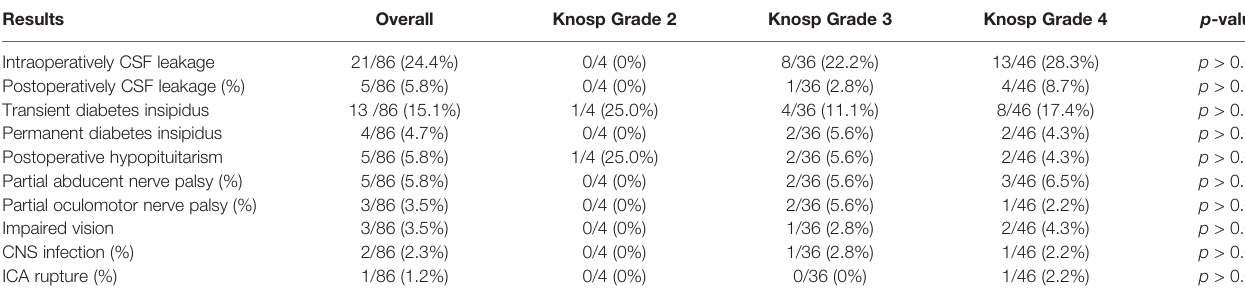
TABLE 4 | Perioperative complications of patients with corticotroph adenomas invading CS based on Knosp